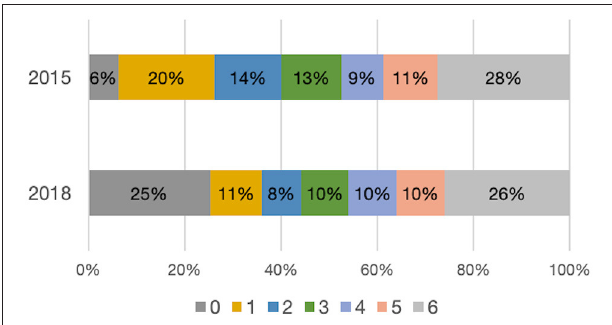
FIGURE 5 | Distribution of mRS values at 3 months for EVT patients in 2015 and